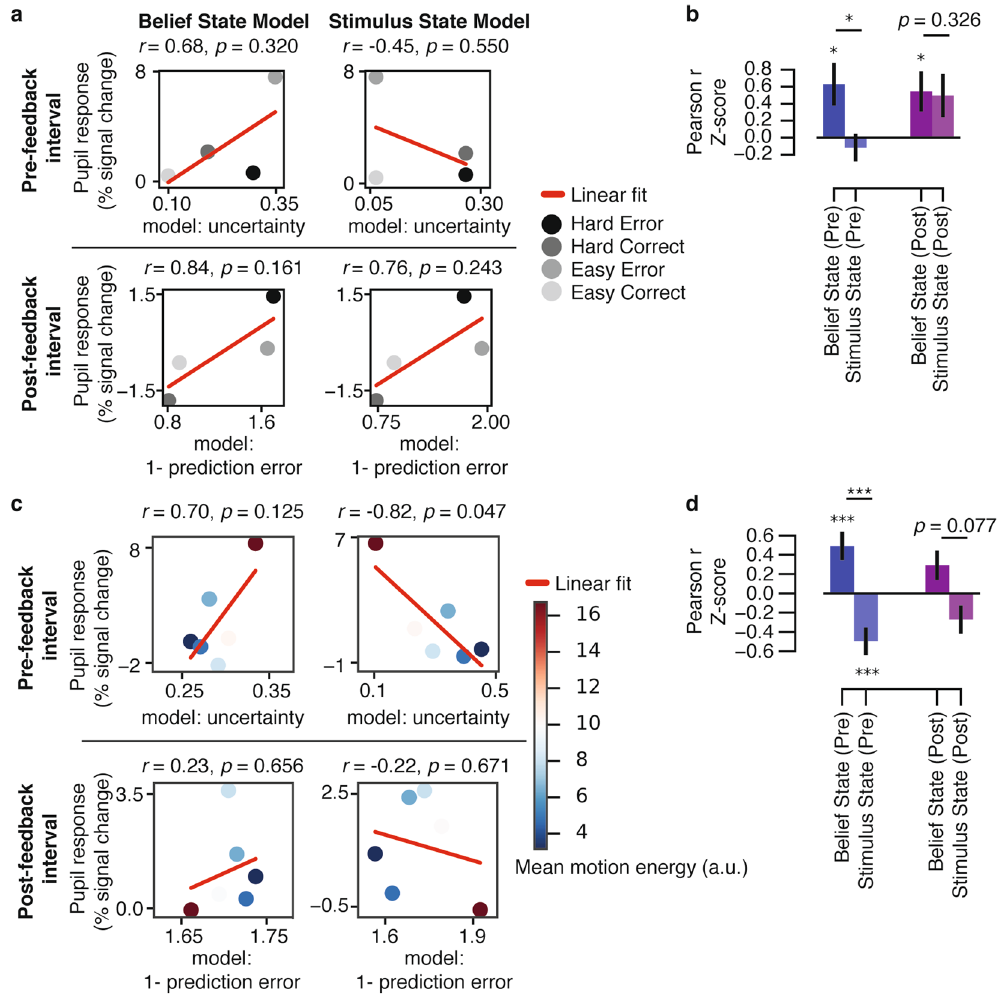
Figure 1. Model fits to pupil responses. ( a ) An example of the correlations ( r ) for a single subject. The four conditions of interest were defined by the Accuracy x Difficulty interaction. Easy and Hard conditions for the model parameters were averaged based on the coherence levels presented to each subject. ( b ) Group-level correlation coefficients ( r ) for the comparison of the model parameters and pupil responses, for the pre- feedback (Pre; − 0.5–0 s) and post-feedback (Post; 3–6 s) intervals. ( c ) An example of the correlations for a single subject using model parameters simulated with motion energy (error trials only). Pupil responses were averaged within six equal-sized bins based on the model parameter for each interval. Evidence strength is represented by mean motion energy within each bin (color bar). ( d ) Group-level correlation coefficients ( r ) for the comparison of the model parameters (using motion energy) and pupil responses, for the pre-feedback (Pre; − 0.5–0 s) and post-feedback (Post; 3–6 s) intervals (error trials only). Error bars, standard error of the mean ( N = 15). ** p < 0.01, *** p <